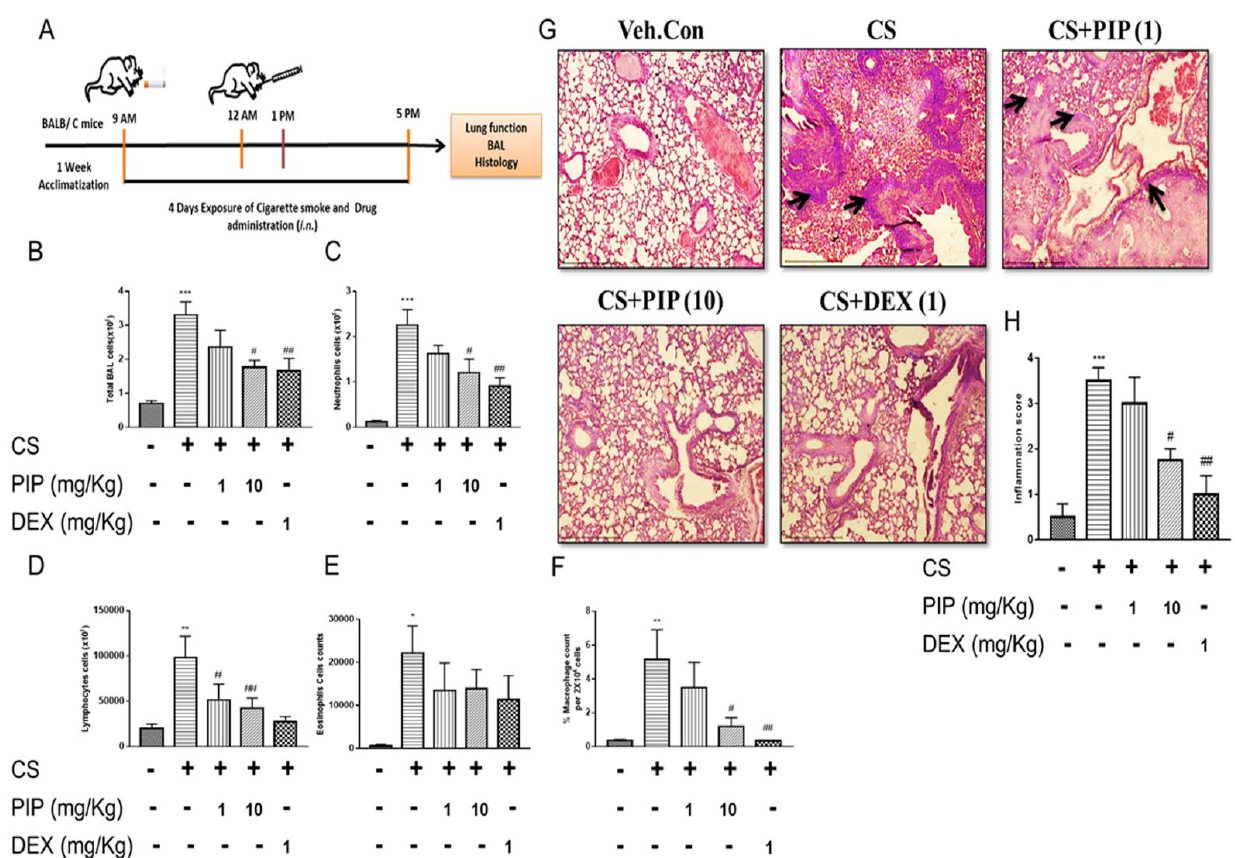
Figure 6. Effect of piperine treatment in an experimental model of smoke-induced inflammation: ( A ) Pictorial representation of in vivo study design. ( B ) Total cell count, ( C ) Neutrophils ( D ) Lymphocytes, ( E ) Eosinophils and ( F ) Macrophages in BAL fluid of various groups. ( G ) Pictorial representation of histopathological analysis (magnification x 100) performed by H and E staining of various groups. → represents influx of cellular infiltration. ( H ). Bar graph depicting inflammation scoring of various groups. The values are expressed as mean ± SEM ( n = 3). * p < 0.05, ** p < 0.01 and *** p < 0.001 vs. Veh.Control, # p < 0.05 and ## p < 0.01 vs. CS. Veh.Control: Vehicle control, CS: cigarette smoke treated (9 cigarettes per day for 4 days), CS + PIP (1): cigarette smoke + 1 mg/kg PIP, CS + PIP (10): cigarette smoke + 10 mg/kg PIP, CS + DEX (1): cigarette smoke + 1 mg/kg DEX.